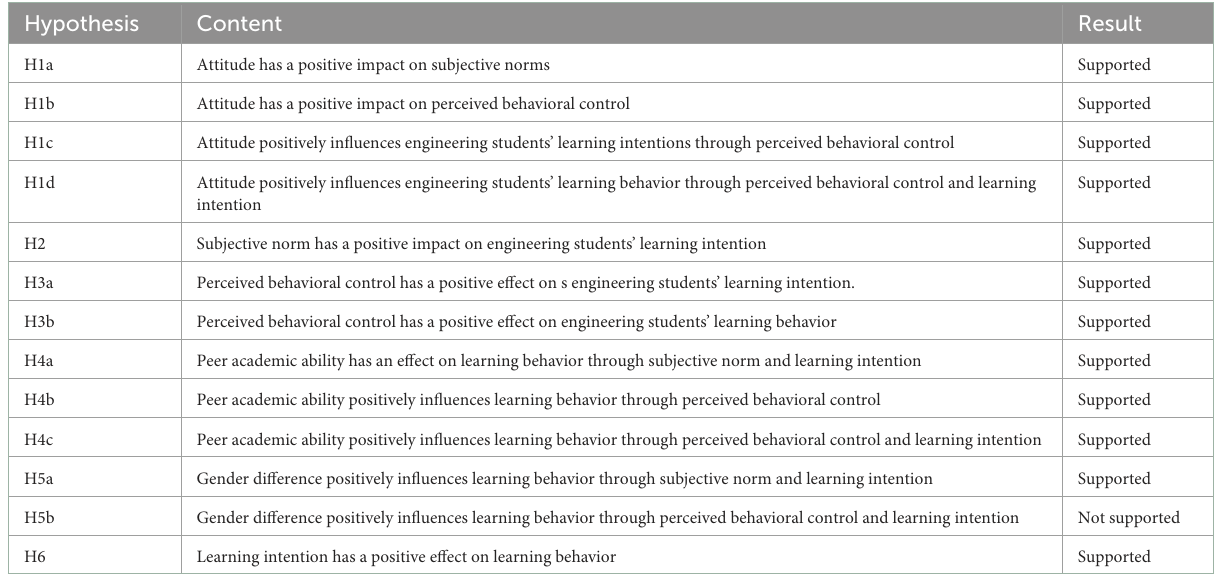
TABLE 4 Summary of hypotheses testing